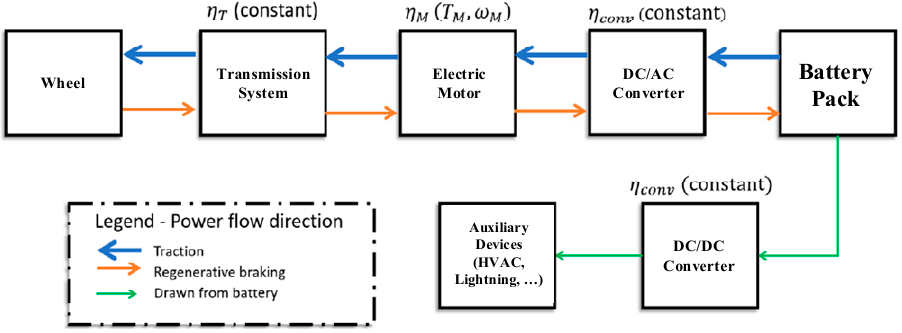
Figure 5. Electric bus energy consumption model system components. Table 2. Input parameters to obtain the electric bus energy consumption model.